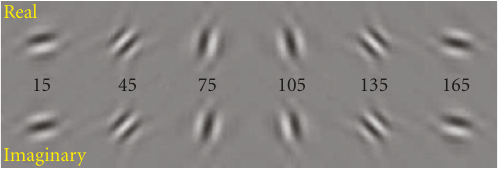
Figure 7: Impulse responses of original construction of Kingsbury’s complex dual-tree wavelets.